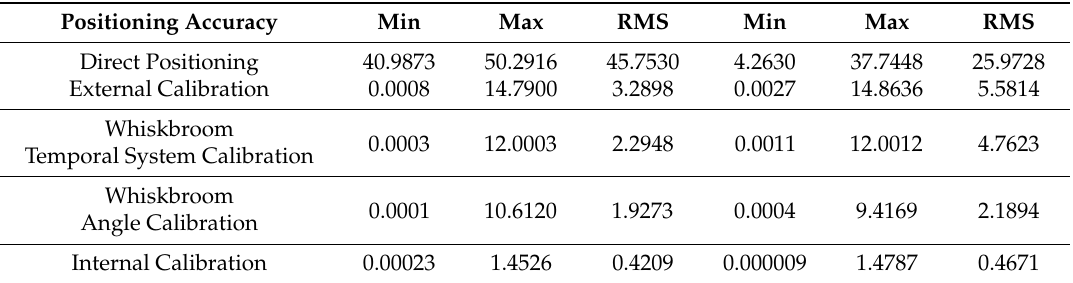
Table 2. Geometric calibration accuracy of the thermal-infrared linear array whiskbroom camera in the YG-14